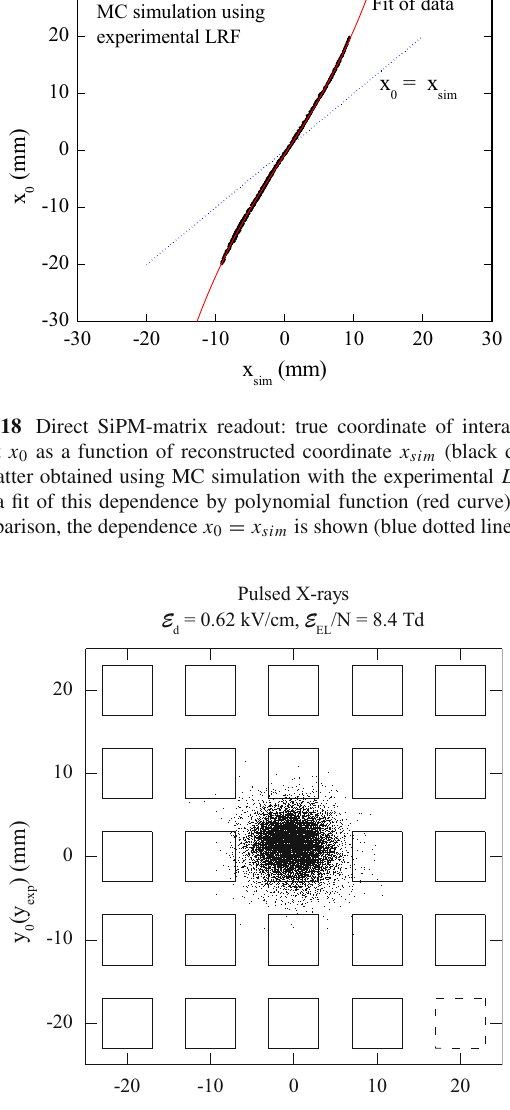
with the trivial x 0 = x sim dependence (i.e. in the absence of systematic bias).